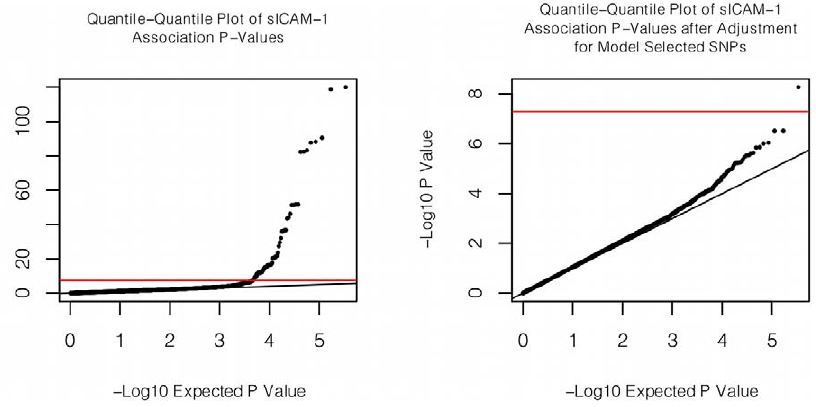
Figure 1. Quantile-quantile plot of association with sICAM-1. The quantile-quantile plot of sICAM-1 association P-values is shown on the left. On the right, the same quantile-quantile plot is shown, but after adjusting sICAM-1 values for the 9 SNPs retained by the model selection algorithm.